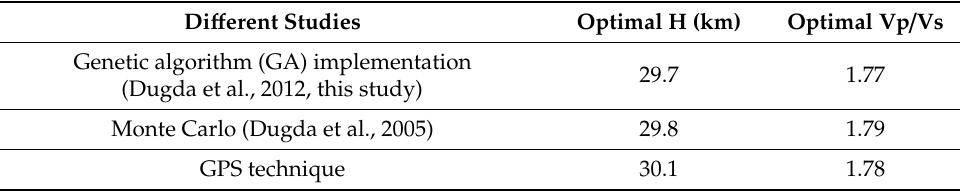
Table 2. Comparing crustal parameters for the station ARBA from three di ff erent